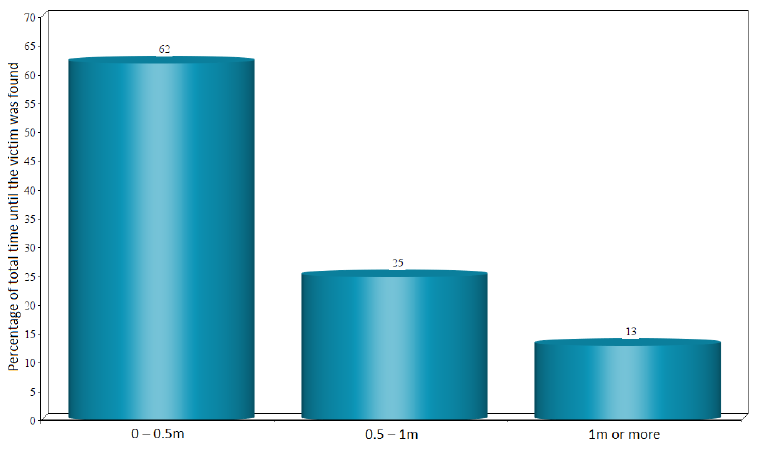
Figure 9. Error rate of the detected position of the robot compared over the operation